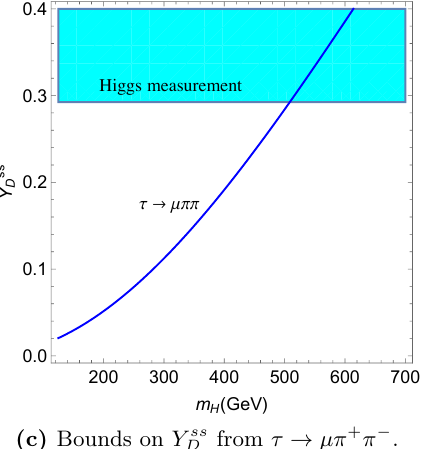
= 0 : 01 and sin (cid:11) = 0 : 1. The region above the lines are excluded ‘